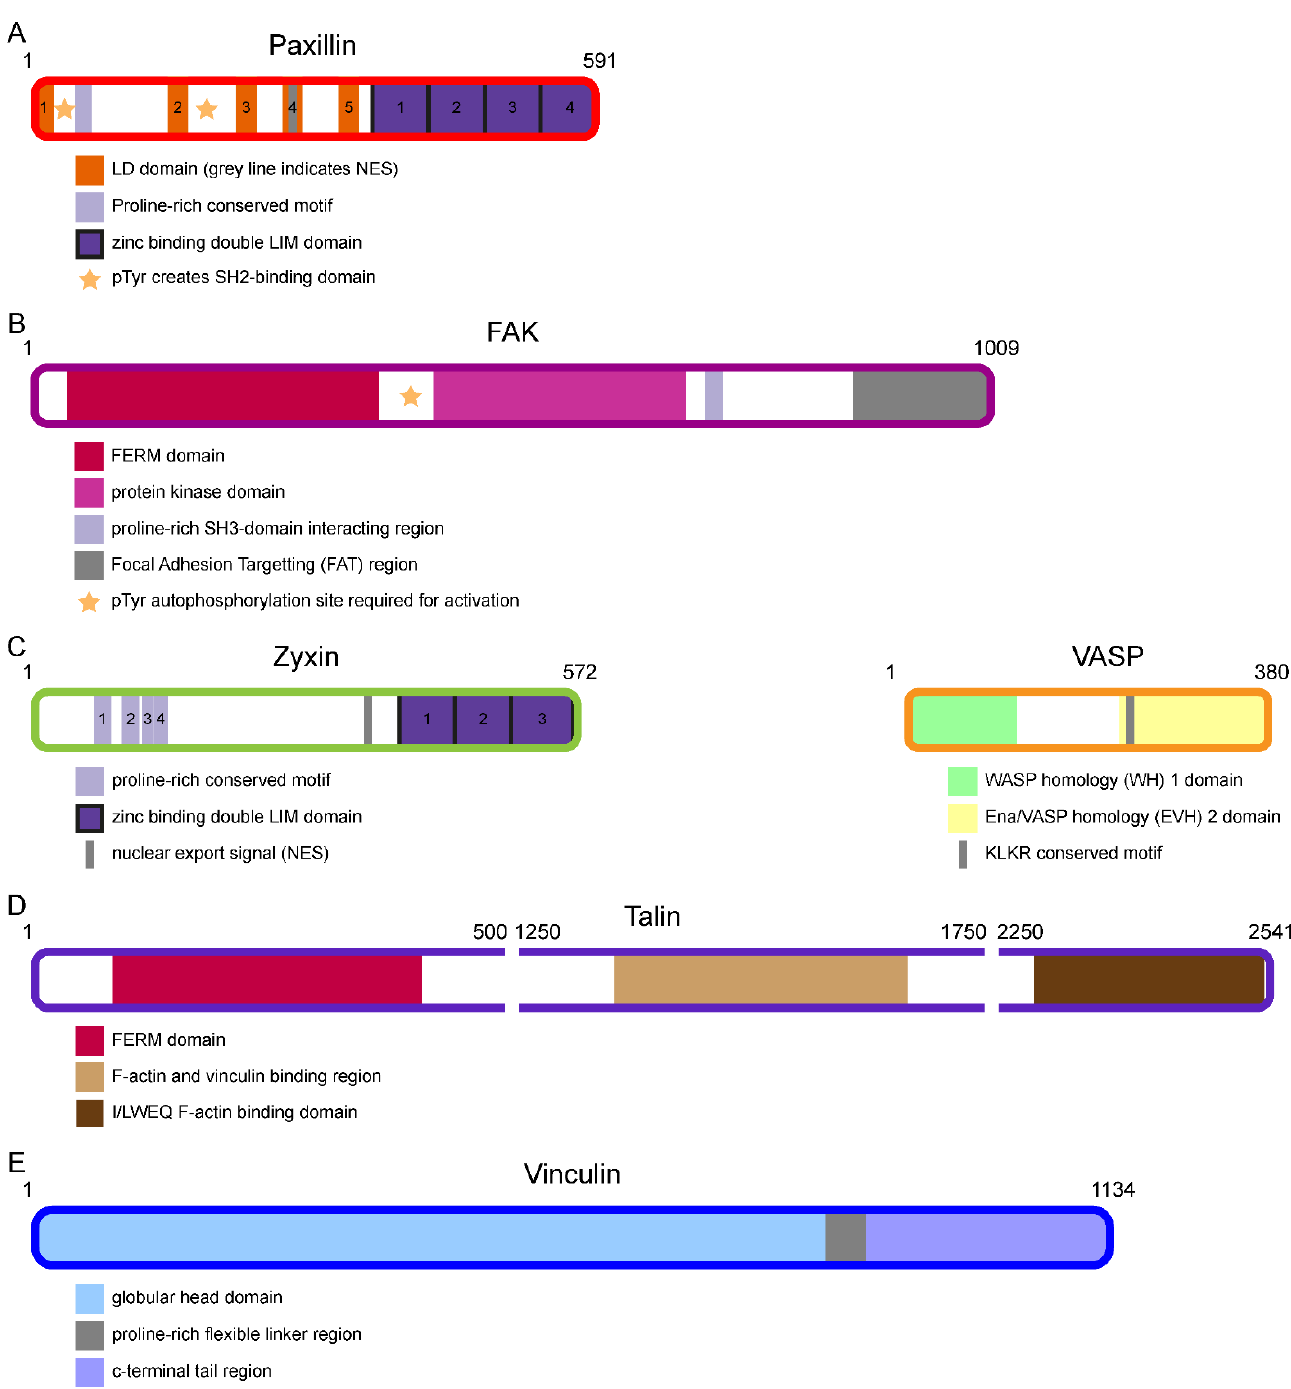
Figure 3. The structure of several intracellular FA proteins. ( A – E ) Schematic representation of the six intracellular FA proteins highlighted in this review, drawn to scale with respect to the amino acid backbone. Numbers indicate amino acid number along the protein backbone. Note that for talin ( E ), the visualised protein backbone is interrupted, and regions lacking relevant domains or structures (amino acid 500 – 1250 and 1750 – 2250) are not shown.